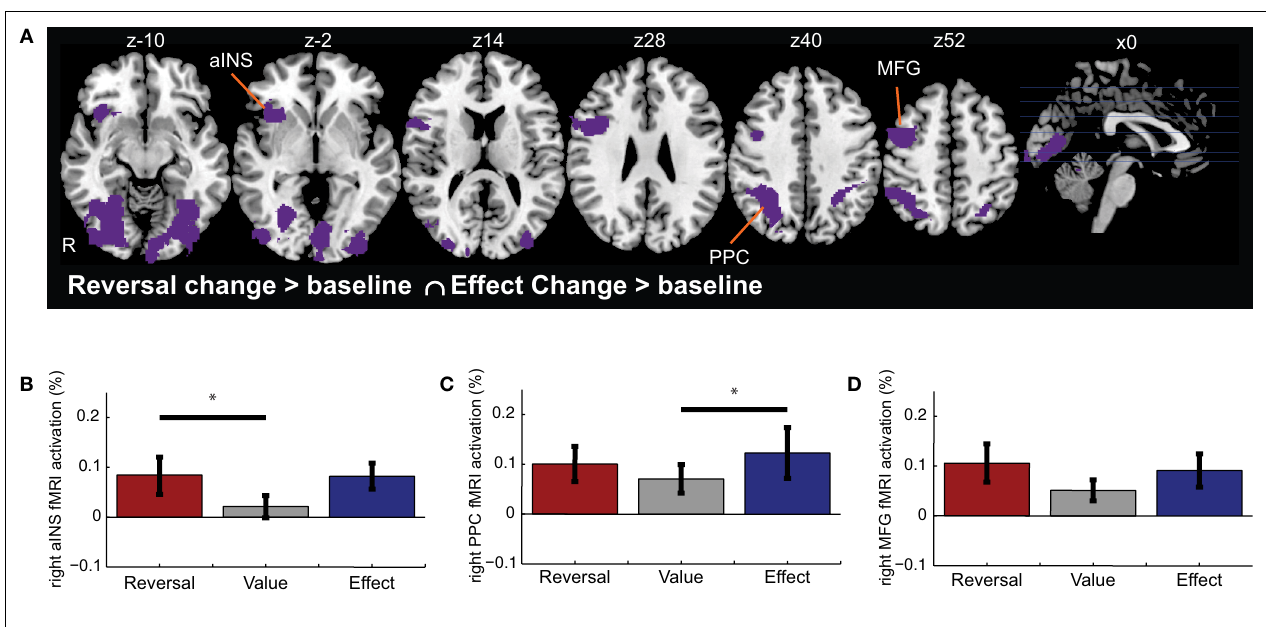
FIGURE 3 | Conjunction of activations for Reversal Changes and Effect Changes. (A) Shown are regions that exhibited signifi cant activation in both the Reversal Change and Effect Change conditions. Subsequent functional ROI analyses extracted the relative signal change evoked for each trial